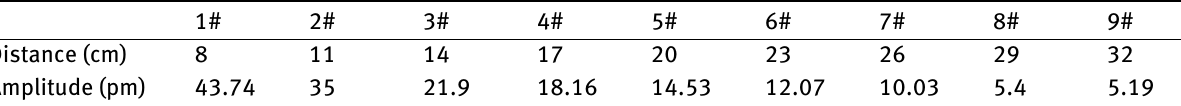
Table 2: Distance from the impact point and amplitude for the template